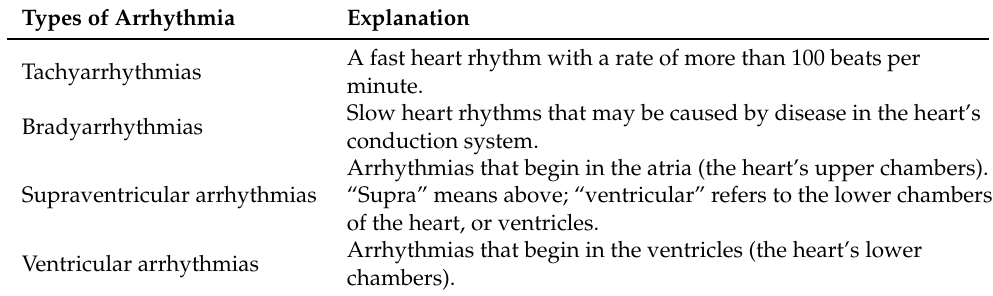
Table 1. Various Types of Arrhythmias.